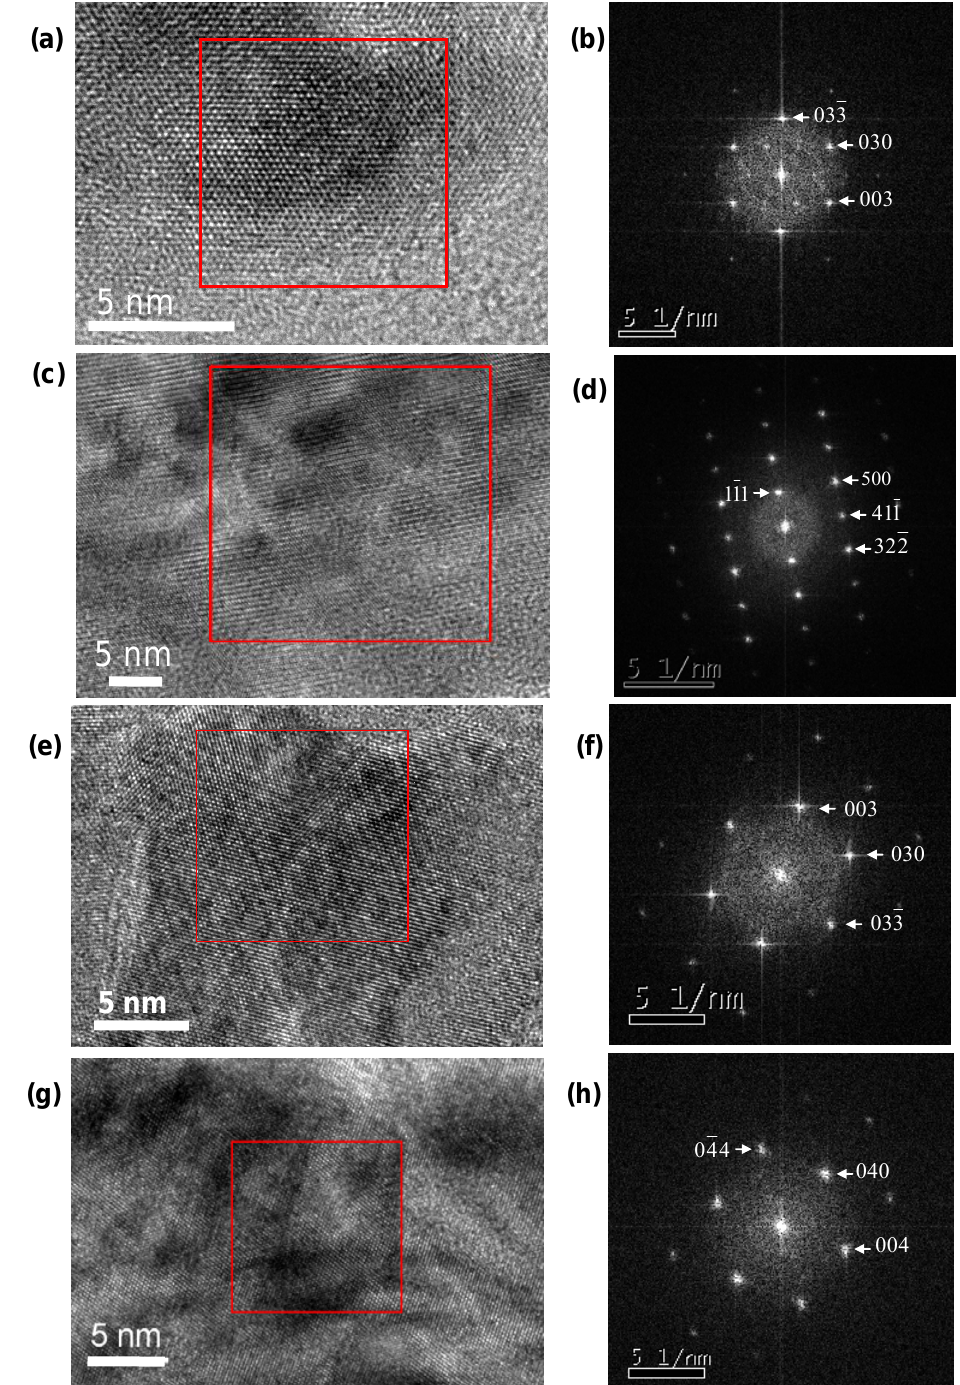
Figure 3. TEM high resolution images ( a , c , e and g ) and associated Fourier transforms (FT’s) ( b , d , f, h ) of mefenamic acid nanocrystals grown from DMF microemulsions 1 day after cooling to 8  C. ( a ) and ( c ) show images from an 80 mg/mL mefenamic acid in DMF microemulsion, whilst ( e ) and ( g ) show images from a 95 mg/mL mefenamic acid in DMF microemulsion. The FT’s of the red boxed regions in the images enable the nanocrystals to be identified as the following. ( a ) Form I nanocrystal aligned along the [100] zone axis. ( c ) Form I nanocrystal aligned along the [011] zone axis. ( e ) Form I nanocrystal aligned along the [100] zone axis. ( g ) Form II nanocrystal aligned along the [100] zone